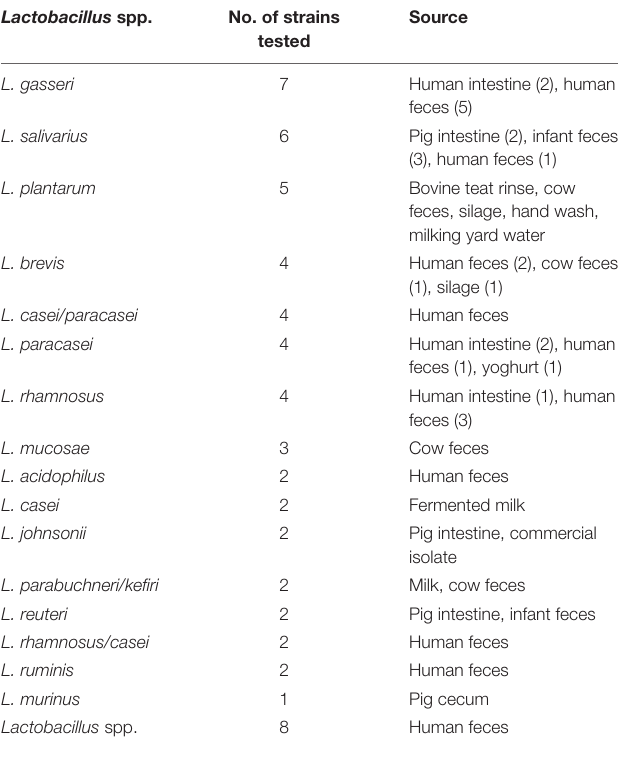
TABLE 1 | Lactobacilli screened for anti- Clostridium difficile activity. Lactobacillus